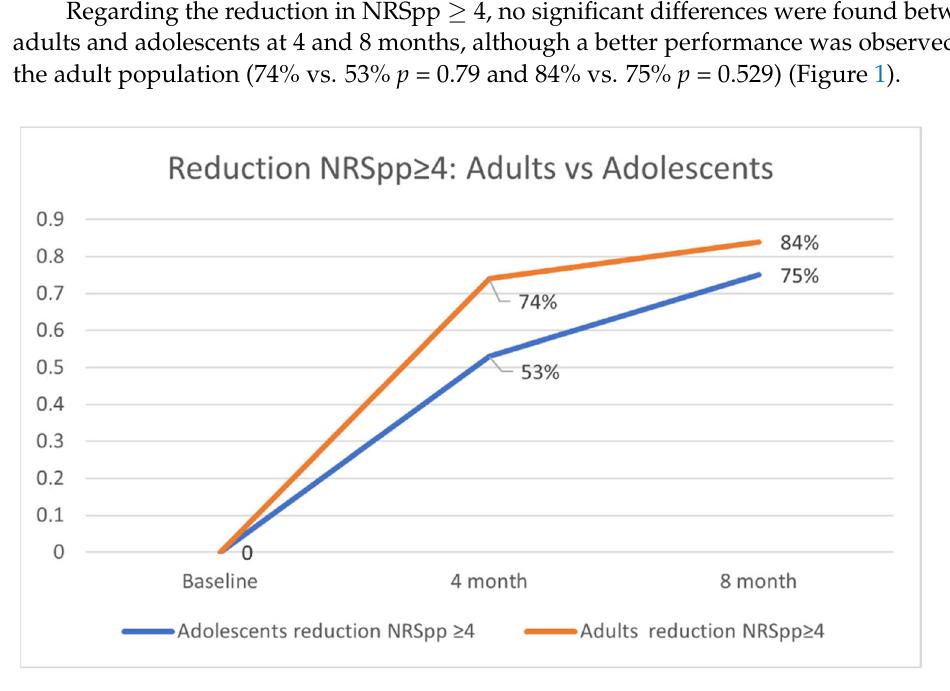
Figure 1. Reduction in NRSpp ≥ 4 adults vs. adolescents.